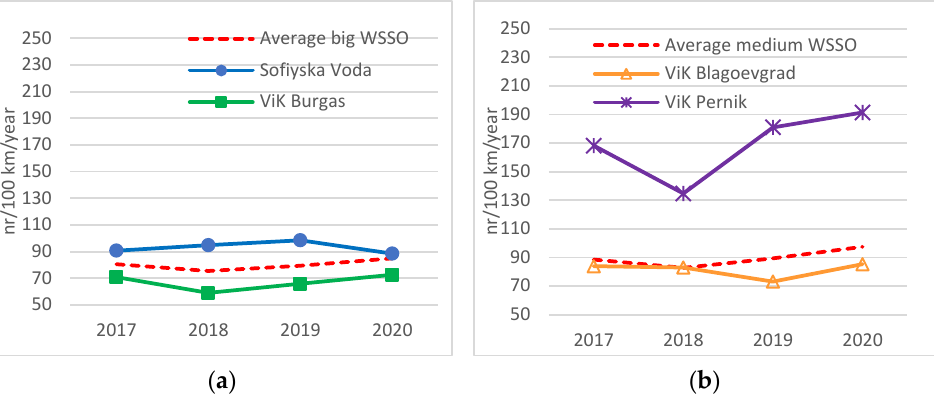
Figure 3. Number of failures along the water supply networks: ( a ) Sofiyska Voda and ViK Burgas; ( b ) ViK Blagoevgrad and ViK Pernik .